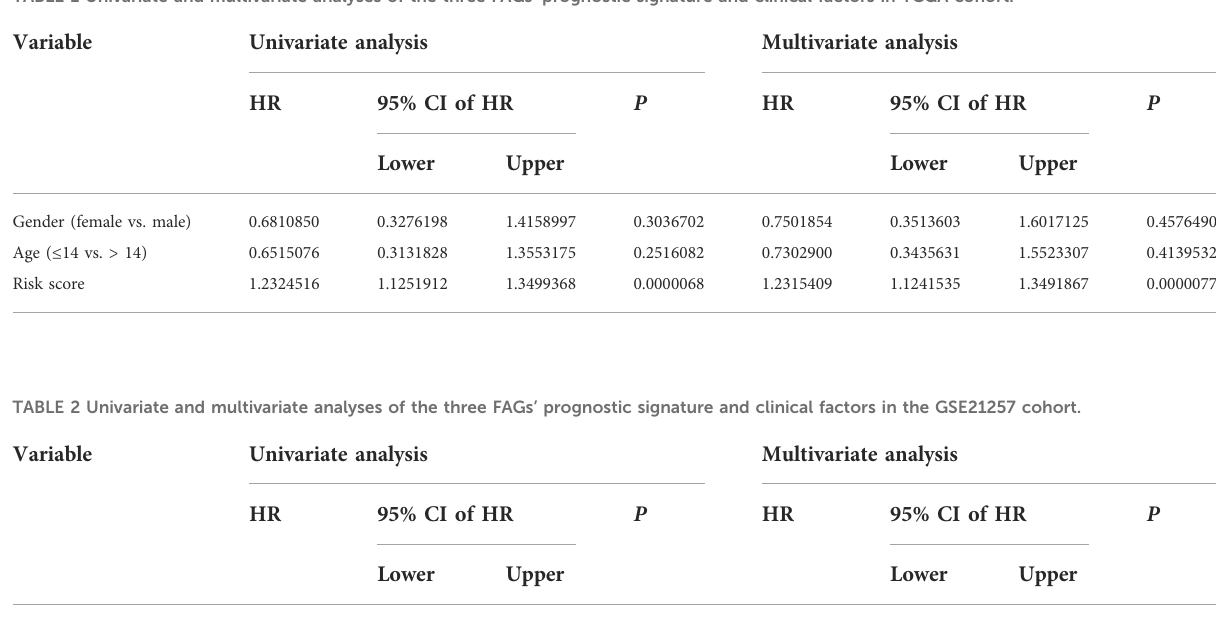
TABLE 1 Univariate and multivariate analyses of the three FAGs ’ prognostic signature and clinical factors in TCGA cohort. Variable